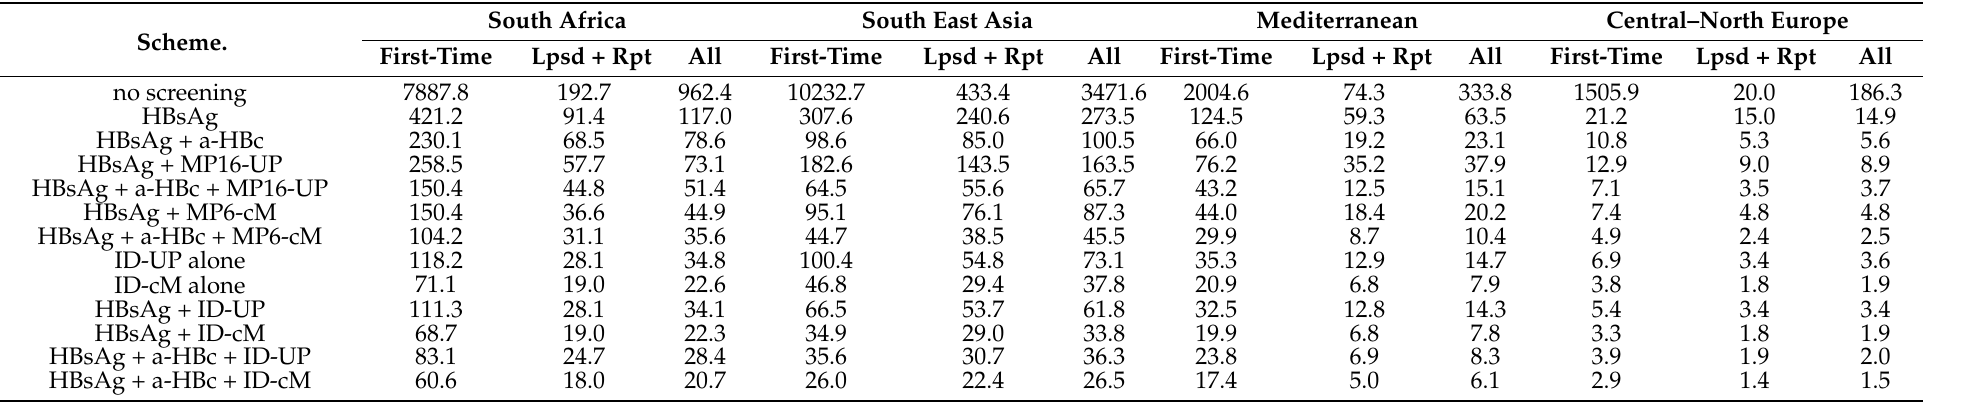
Table 2. Residual HBV transmission risk/million for different screening options and donation categories as calculated from yield rates in four geographical regions using Weusten risk models [4,10] for RBC transfusion.